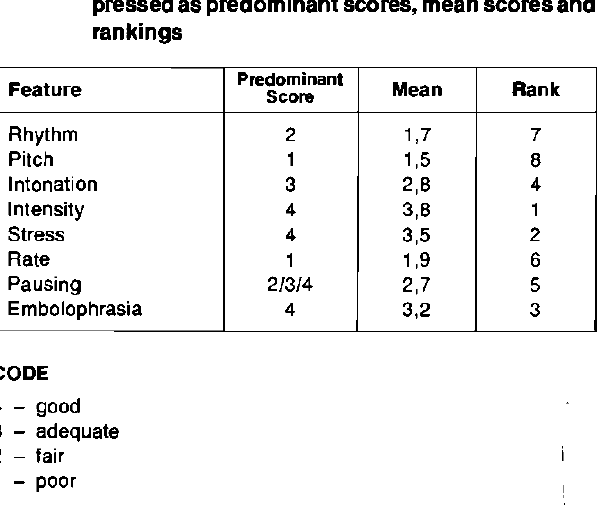
Table 2 Overall paralinguistic competence for all Ss' ex- pressed as predominant scores, mean scores